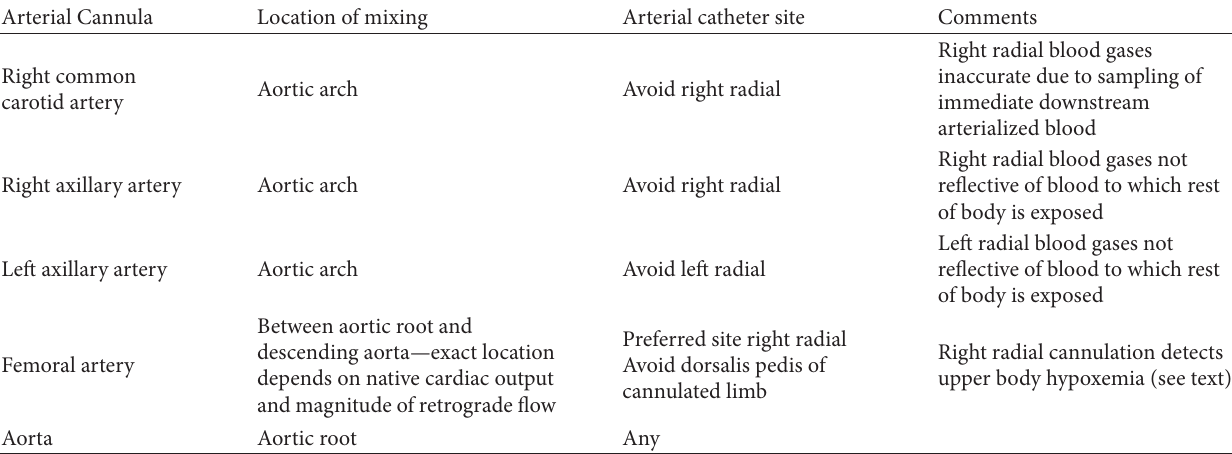
Table 4: Different sites of VA ECMO arterial cannulation and arterial catheter